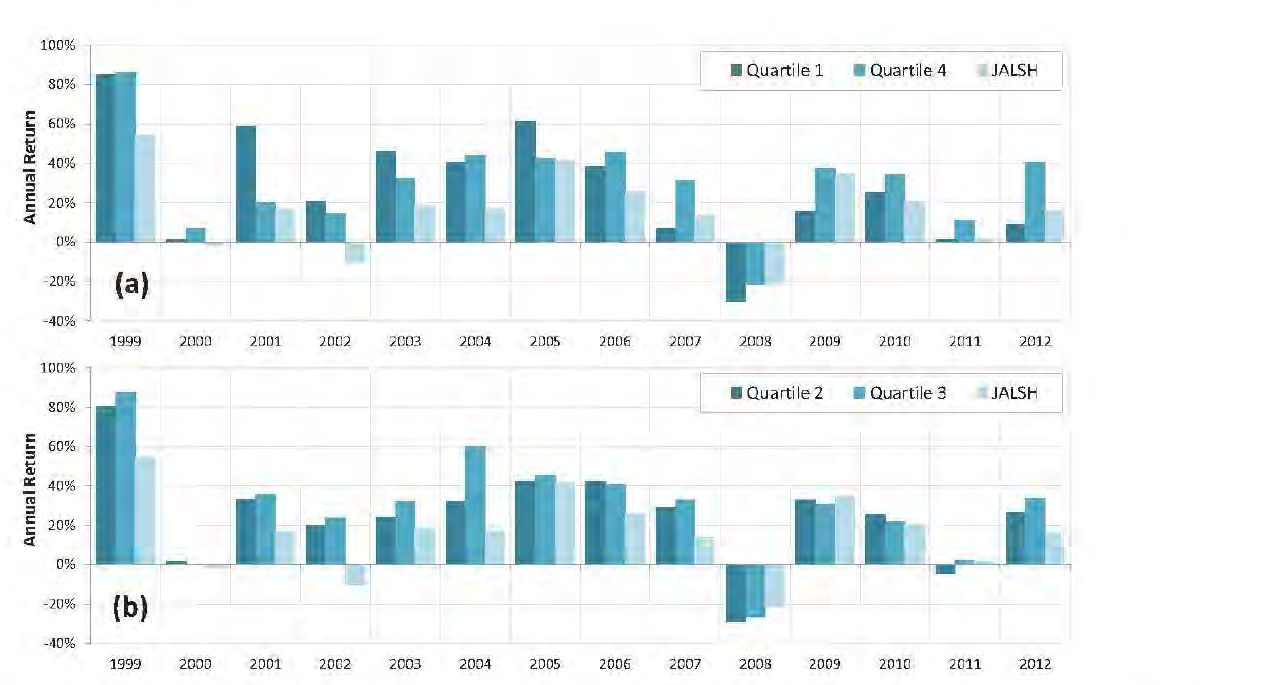
Figure 1: Portfolio and JALSH returns by year for value and growth stocks based on P/B, 1999-2012 for (a) quartiles